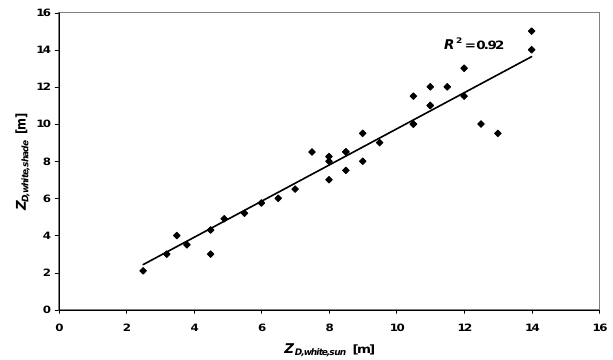
Fig. 6. All naked eye and colour filter observations of Z D , on the shaded versus the sunlit side of the ship. The best-fit line through the origin is the function Z D,shade = 0 . 93 Z D,sun